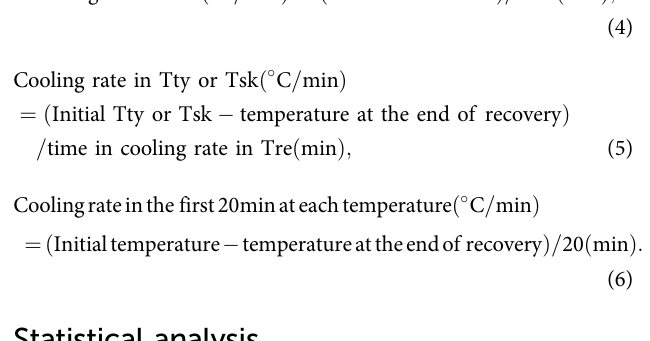
Tre between trials during recovery. Tty was lower in the FAN trial from 10 to 20 min than in the CON trial ( P < 0.05). Tsk was lower in the FAN trial from 15 to 20 min than in the CON trial ( P < 0.05). Cooling rate in the FAN trial until time to achieve Tre